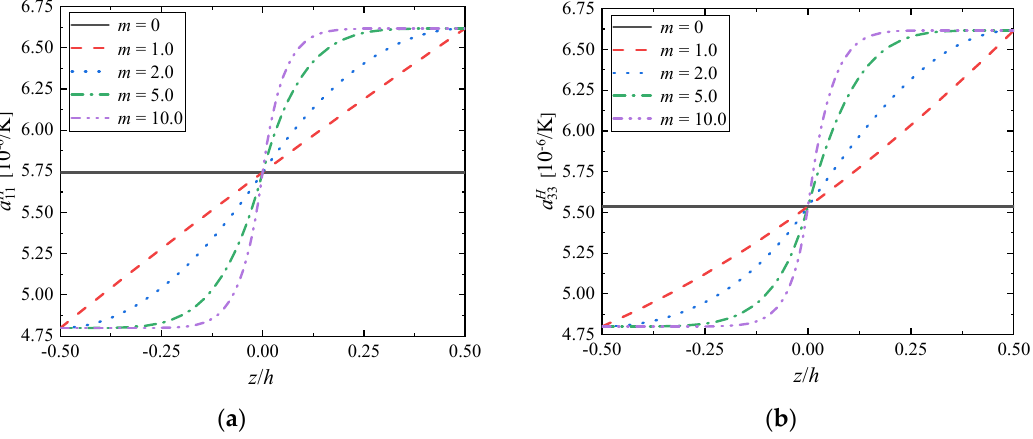
H and ( b ) 𝛼 H along the gradient direction ( c 11 33